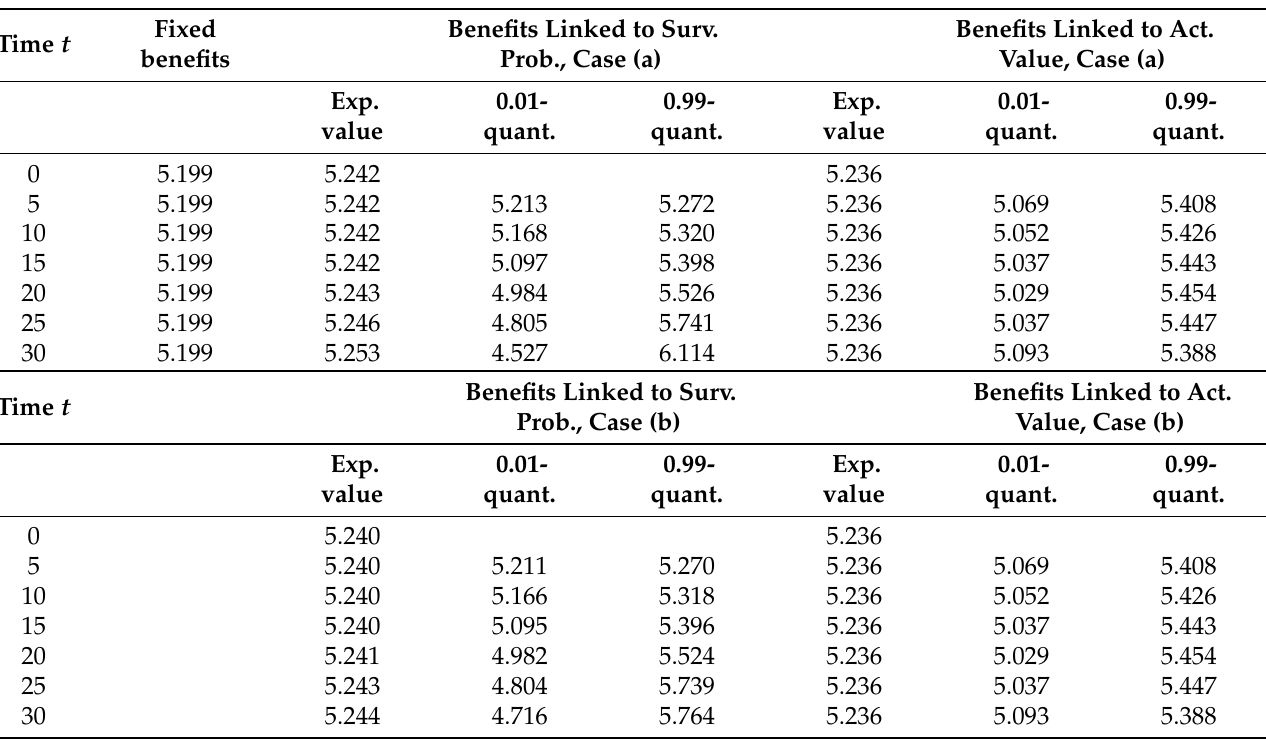
Table 2. Benefit amount b t (expected value and 0.01- and 0.99-quantiles) for selected times. Moderate aggregate deviations.